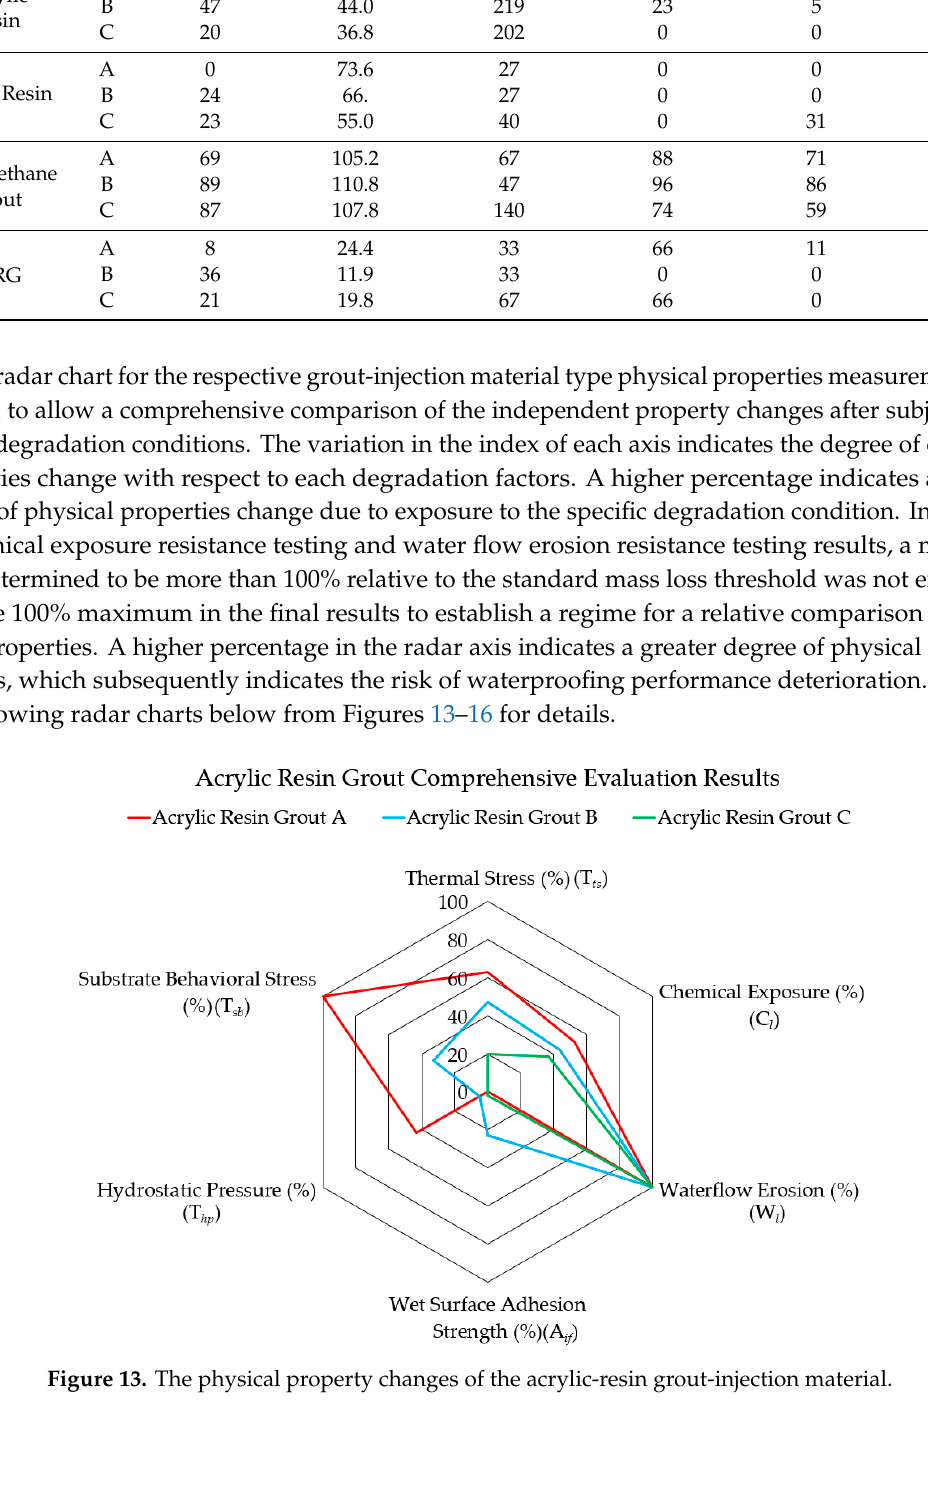
Figure 14. The physical property changes of the epoxy-resin grout-injection material.